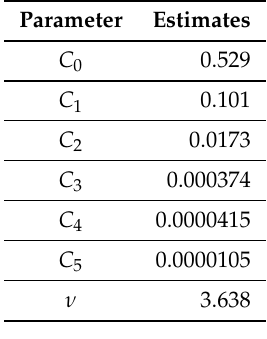
Table 2. Parameter estimation by maximum likelihood using simulate annealing optimizer.